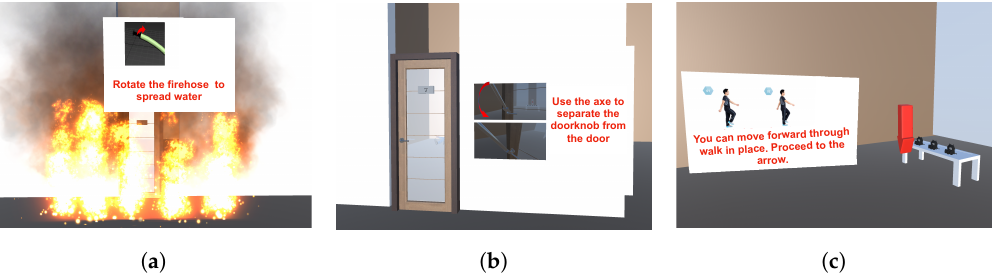
Figure 6. Examples of tutorial scenes before starting the main scenario in the user study. ( a ) Fire hose; ( b ) fire axe; ( c )